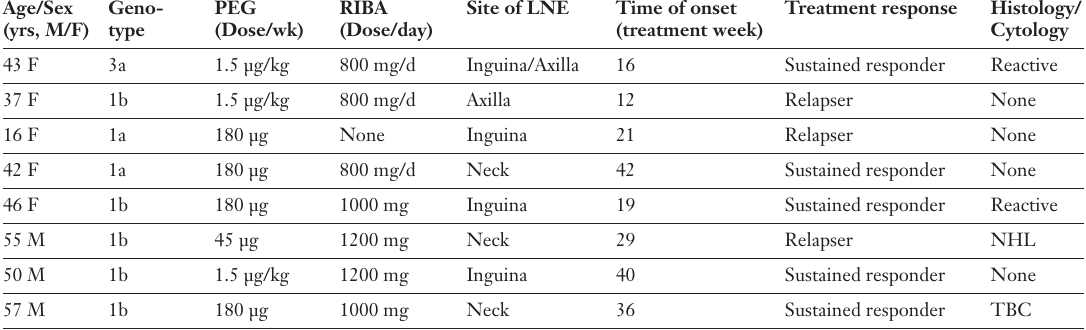
Table 1. Characteristics of 8 patients with LNE during antiviral therapy with PEG and